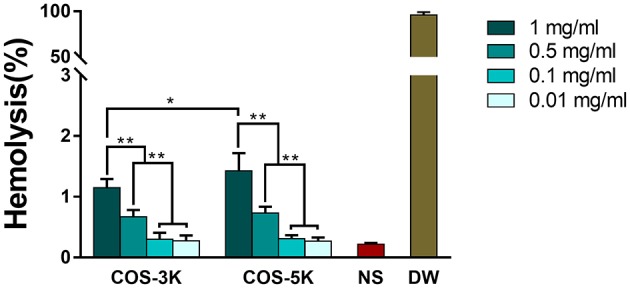
Hemolysis percentage of RBC suspension induced by COS. NS, normal saline; DW, diluted water. *p < 0.05; **p < 0.01.